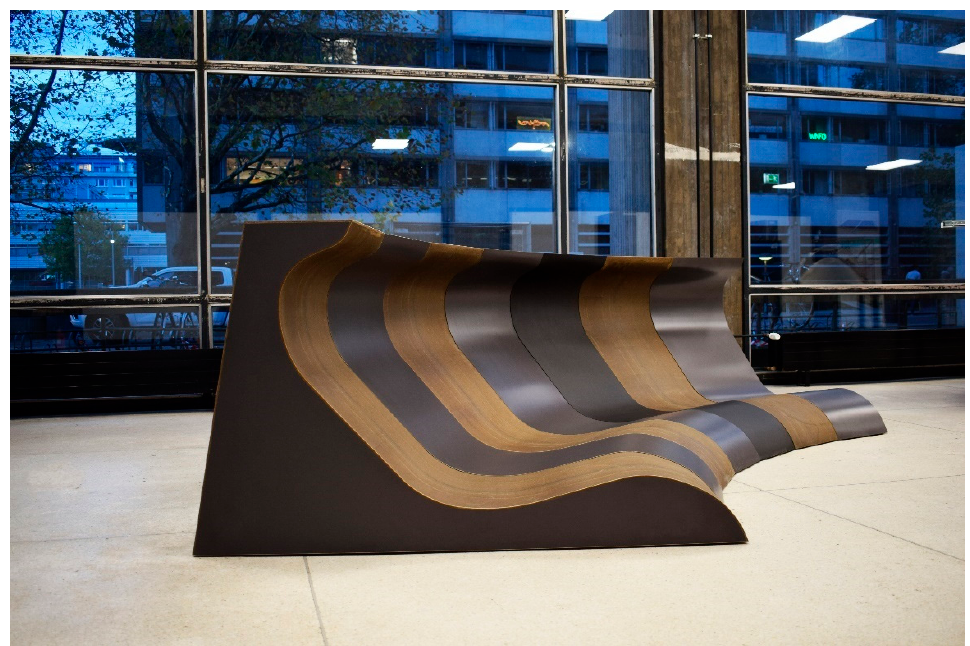
Figure 6. Illustration of the production of Bio-flexi in the mass-production scale indicating the control and feeding units in Naftex GmbH company, Wiesmoor, Germany (Photo: Dahy, H. republished [7]).